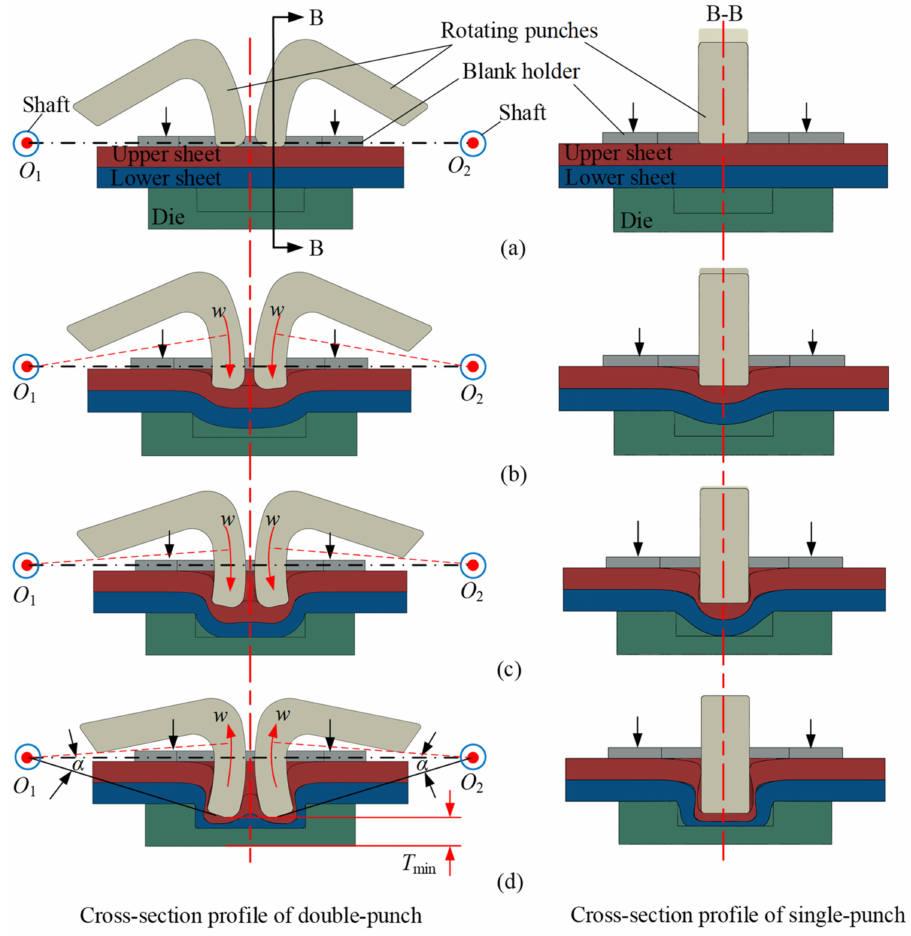
Figure 1. Forming processes of the RCP joint. ( a ) Positioning, ( b ) extrusion, ( c ) filling and ( d )